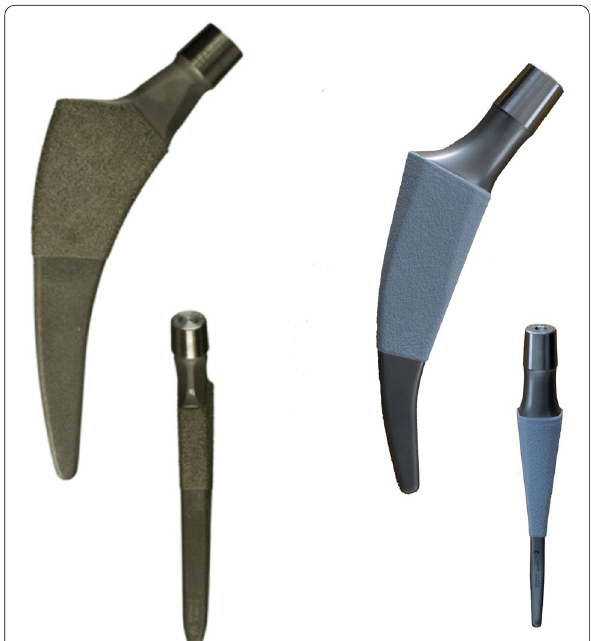
Fig. 1 Anterior and sagittal profiles of the Fitmore (left) and the Metha stem